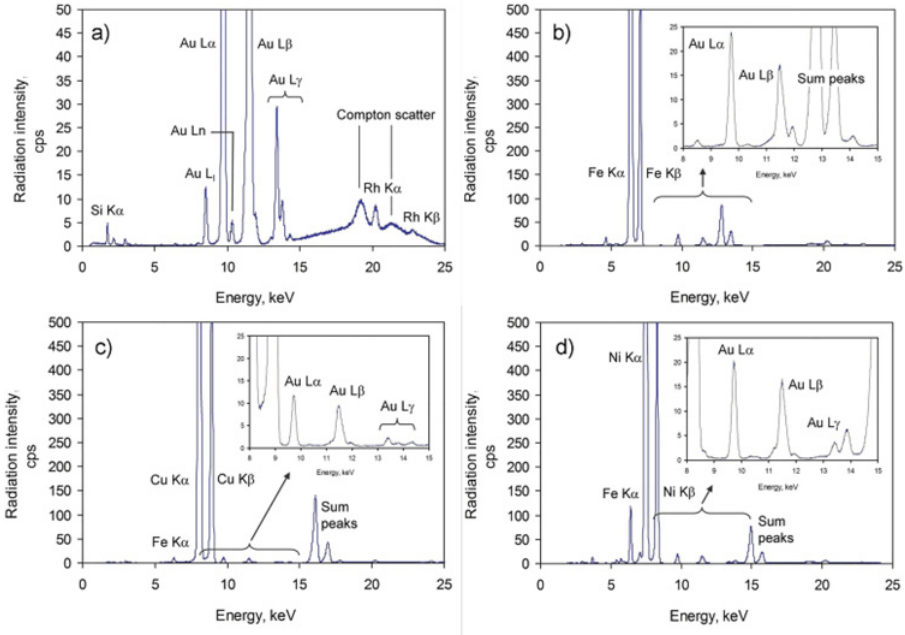
Fig 1. EDXRF spectra of Au/SiO 2 (a), Au-Fe (b), Au/Cu (c) and Au/Ni(d) that were collected using an Rh target X-ray tube operated at 30kV and 300 μ